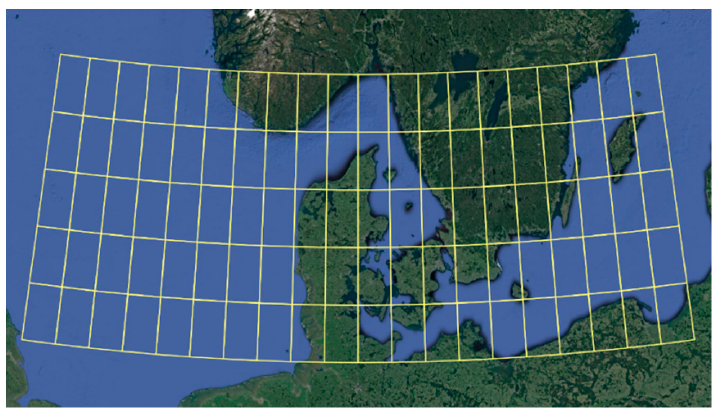
Figure 3. The tiling scheme (in yellow) used to divide the task of compiling the datasets available on the Grid DB. Each tile has an area of 1° of latitude by 1° of longitude. Background from Google Maps’ Tile Map Service.